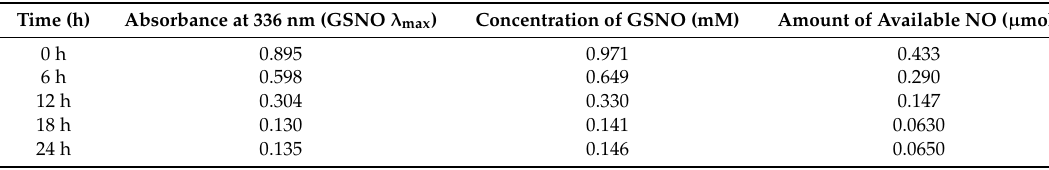
Scheme 1. Hypothesized representation of the spontaneous decomposition of GSNO in complete DMEM to produce a nitric oxide radical (NO) and oxidized glutathione (GSSG). Table 1. Absorbance at 336 nm (GSNO λ max ) of 1 mM GSNO in complete DMEM over 24 h. This data exhibits the decline of GSNO absorbance, particularly in the first 18 h of analysis. Proportionally, the concentration of GSNO and available NO decline over the 24 h period.